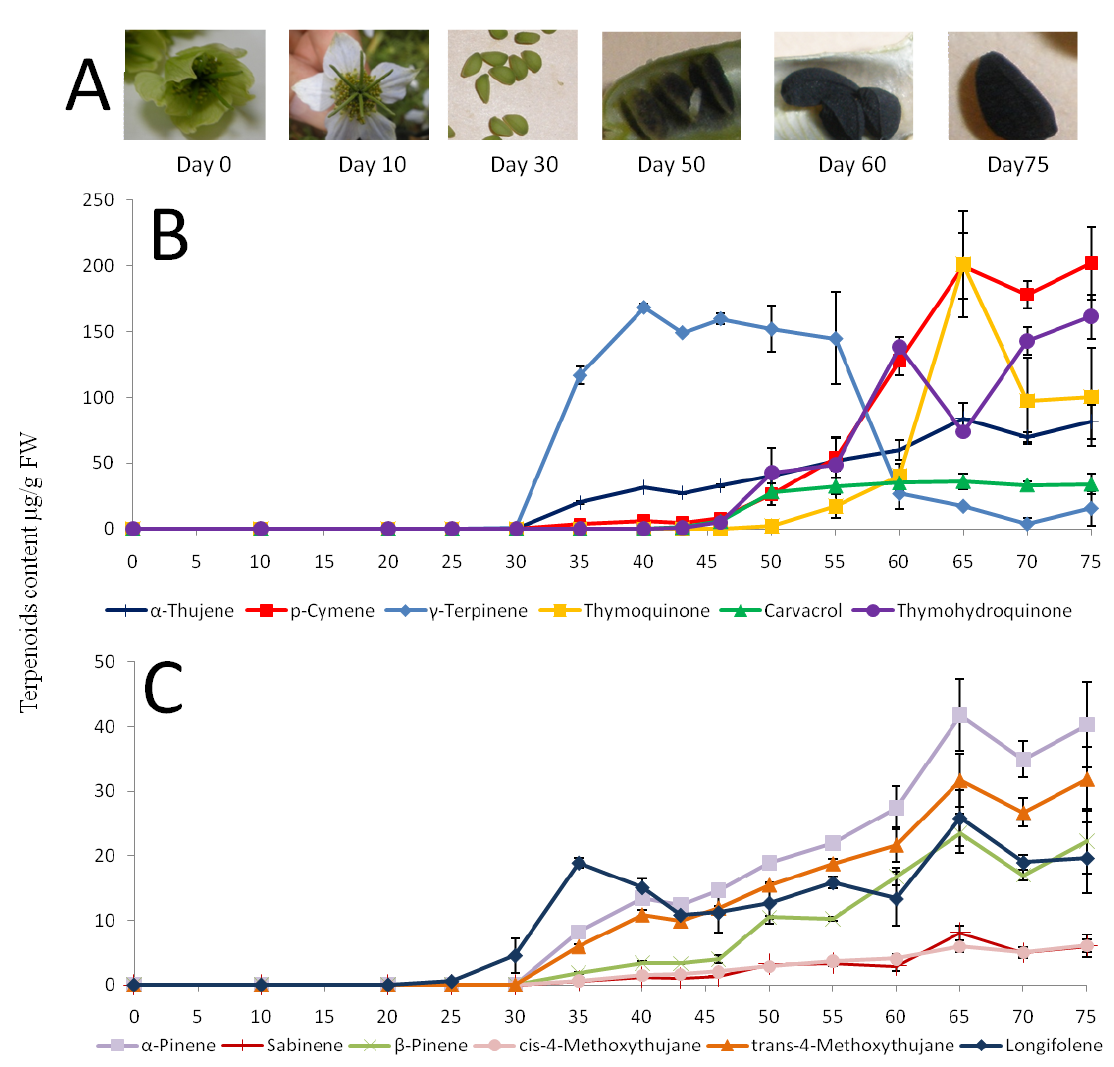
Figure 2. Changes in volatile levels during N. sativa seed maturation. ( A ) Developmental stages of N. sativa seed. ( B ) Major components. ( C ) Minor components. Means and SE of three replicates of samples from Ein Harod source are